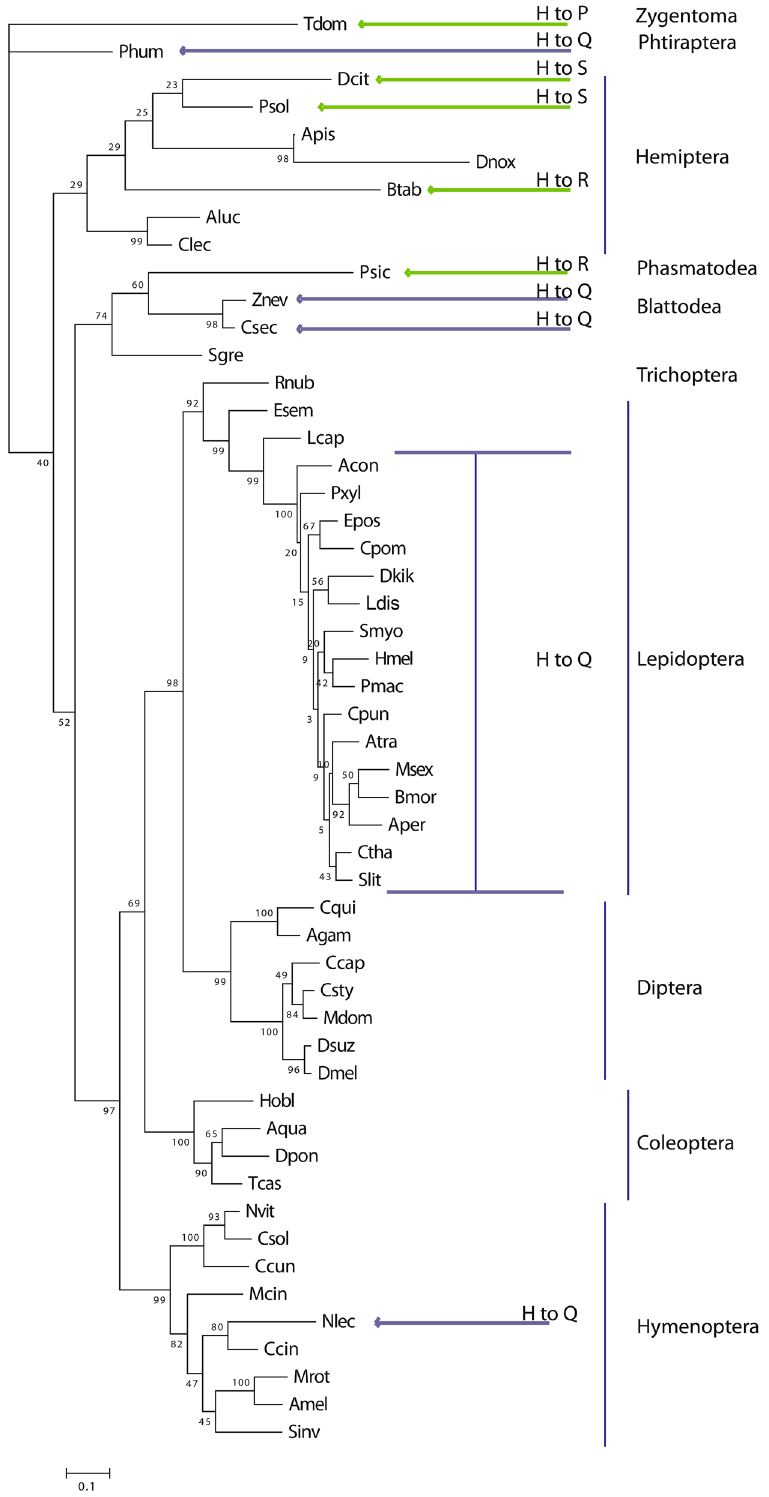
Figure 2. Maximum likelihood phylogenetic tree of Orco sequences. Unrooted. Includes sequences from Table 1. Node support was assessed with 600 bootstrap replicates. Blue arrows: non-Lepidopteran insects provided with the H-Q substitution; green arrows: non-Lepidopteran insects provided with other types of substitutions at the H417